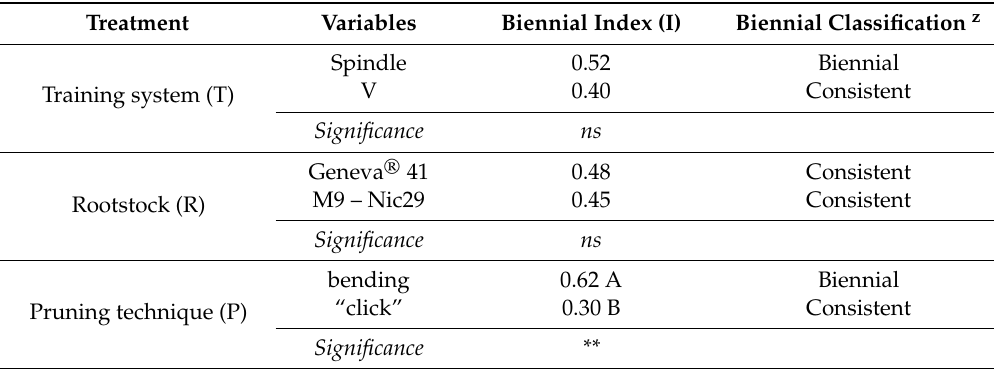
Table 3. The e ff ects of the training system, rootstock, and pruning technique on the biennial index and classification as assessed by Hoblyn et al. [53] for “WA38” trees grown in Washington State across